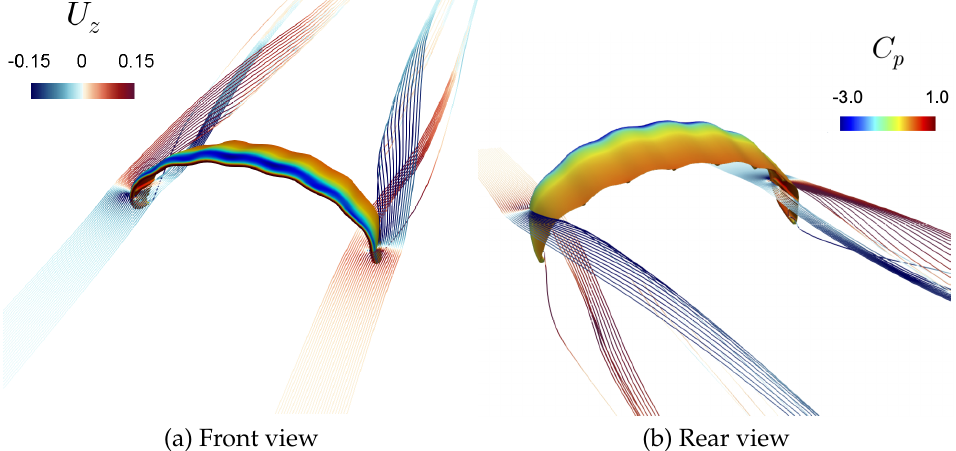
Figure 6. Contour plot of the pressure coefficient C p on the wing surface and streamlines around the tip regions coloured by the transverse velocity component U z for Re = 3 × 10 6 , α = 12 ◦ and β = 0 ◦ , taken from